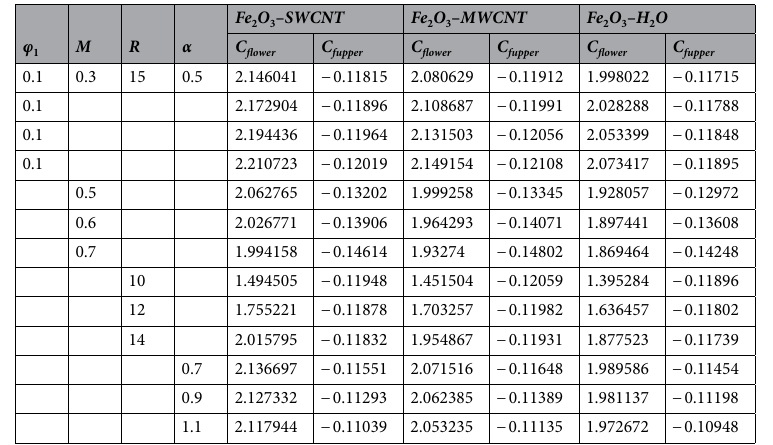
Table 5. Numerical values of Nusselt number for various parameters, whereas Pr = 6–2, Tr = 1–7, Rd = 0–3, A =